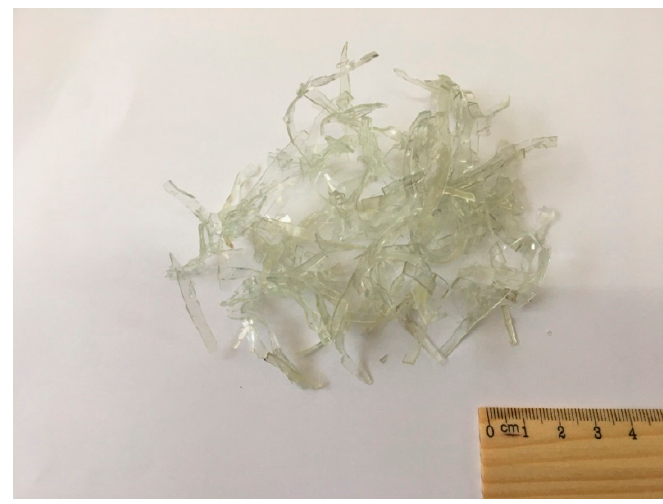
Figure 4. Polyvinyl butyral used in this research.